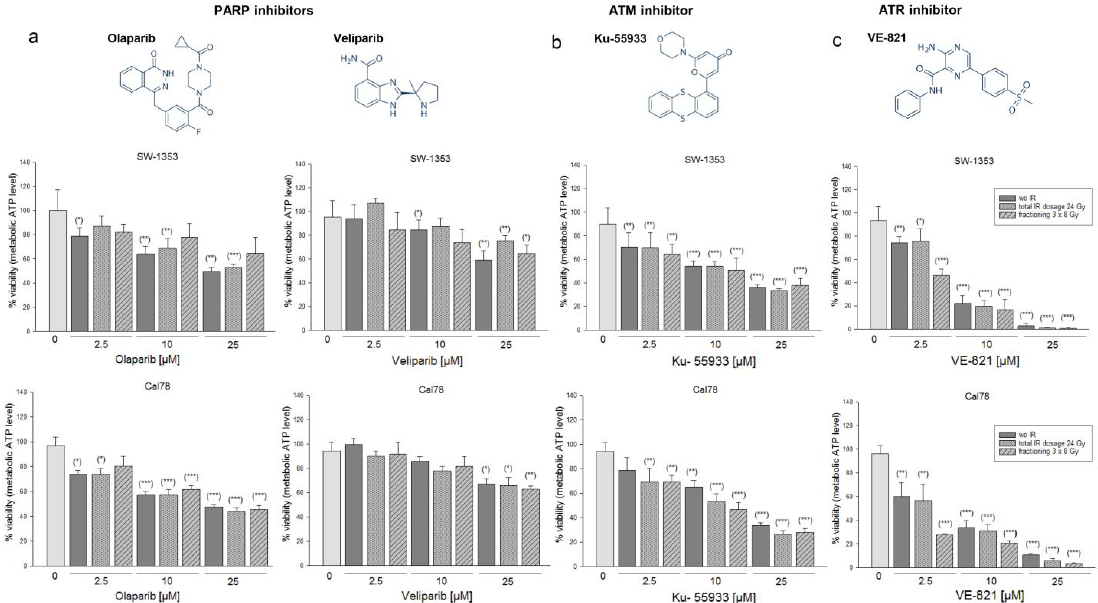
staining. Figure 2e represents the quantification of the optical density (mean ± SD of n = 3, measured in biological triplicates).